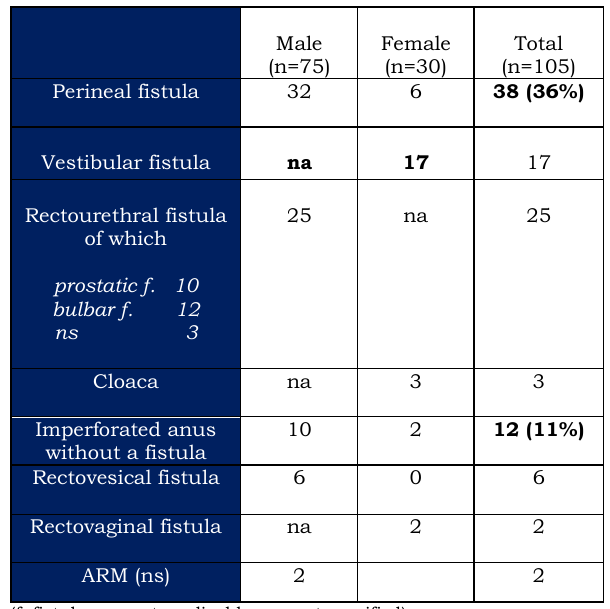
Table 1: Krickenbeck Classification of ARM